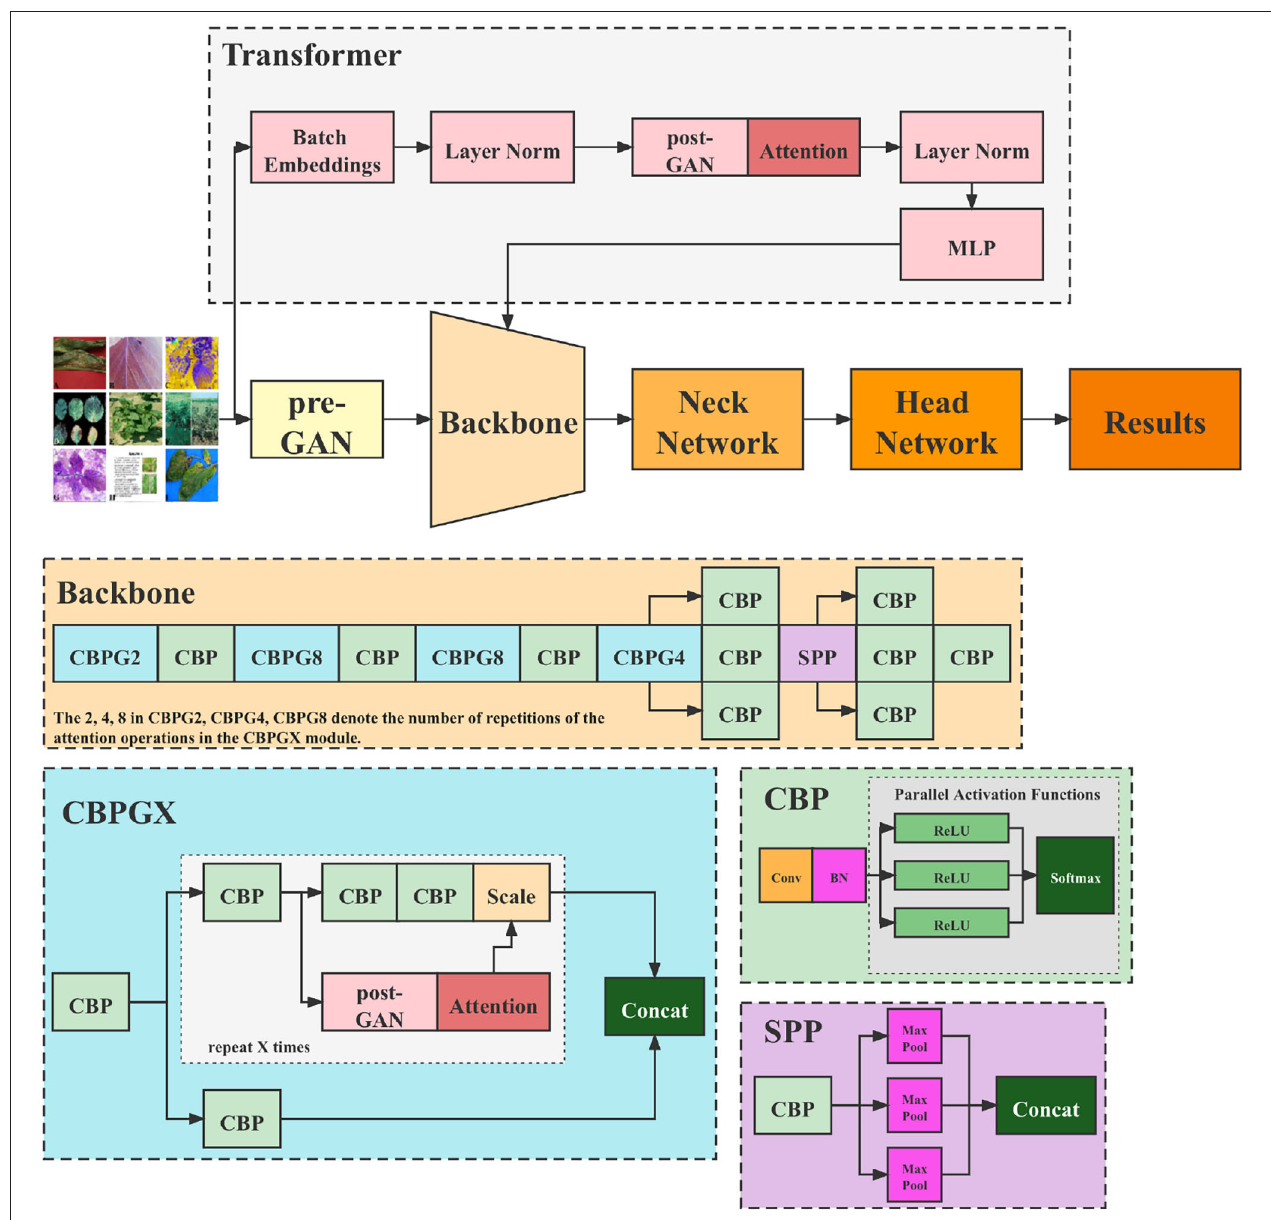
FIGURE 4 | Structure of the Tranvolution detection network with GAN